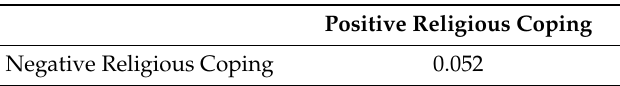
Table 4. Correlation Matrix.